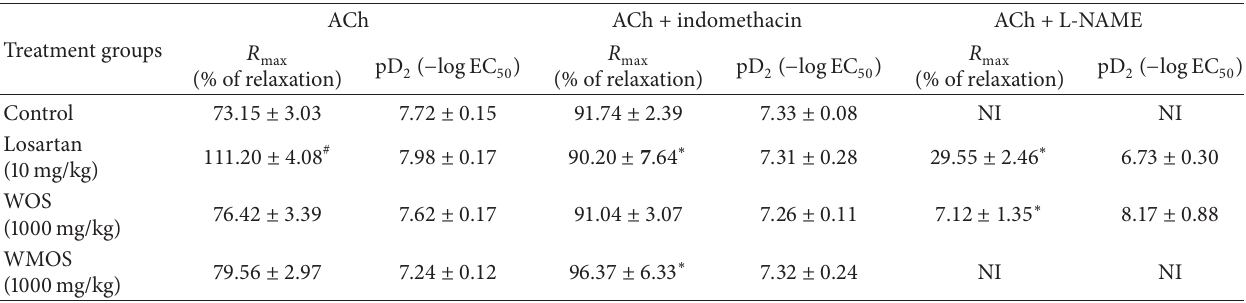
Table 2: Maximal relaxant effects ( 𝑅 max ) and sensitivity (pD indomethacin and